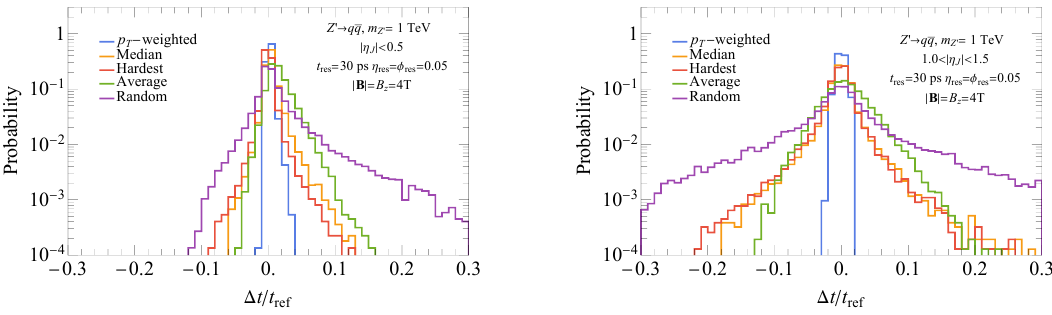
Figure 18 . The relative time difference distribution for | η J | < 0 . 5 (left) and 1 . 0 < | η J | < 1 . 5 (right) with a magnetic field. The | η 0 . 5 plot can be compared with figure 16 (right) and the J | < 1 . 0 < | η 1 . 5 plot can be compared with figure 17 J | <